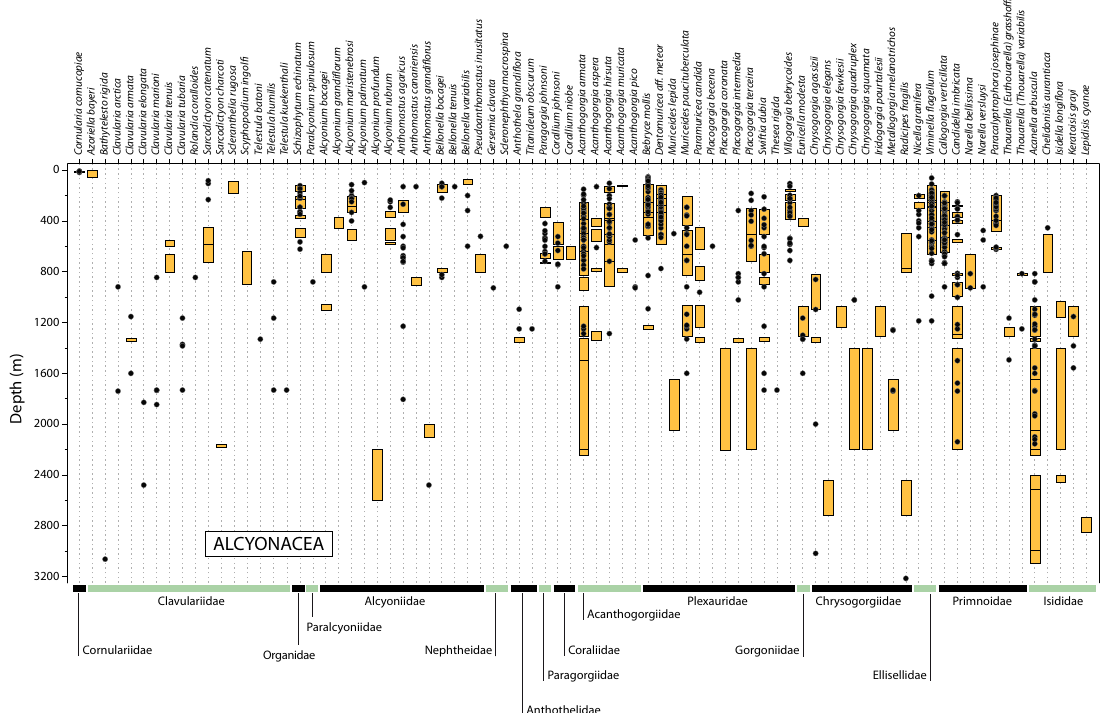
Fig. A1. Species bathymetric ranges. The stylasterid Stenohelia sp.A is not represented given that there is no bathymetric information for this